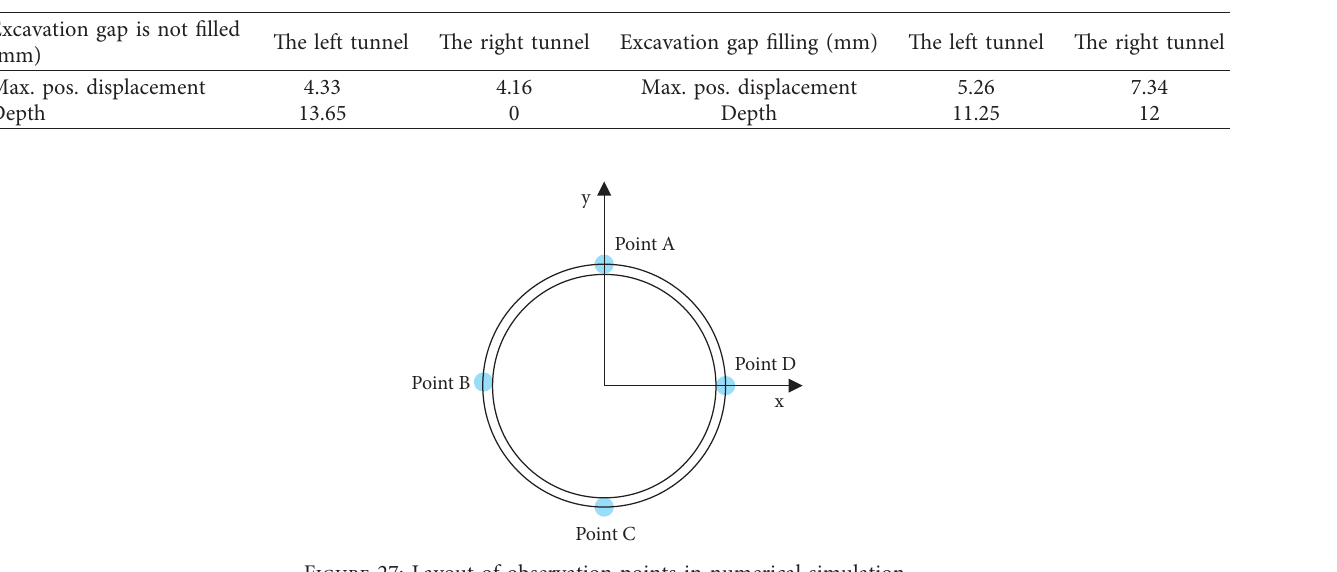
Table 4: Longitudinal displacement of the deep stratum.